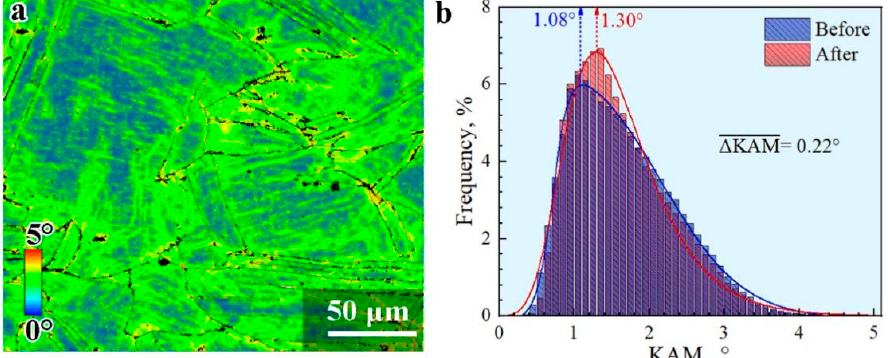
Figure 6. The XRD spectra for various samples prior to and after tensile testing.